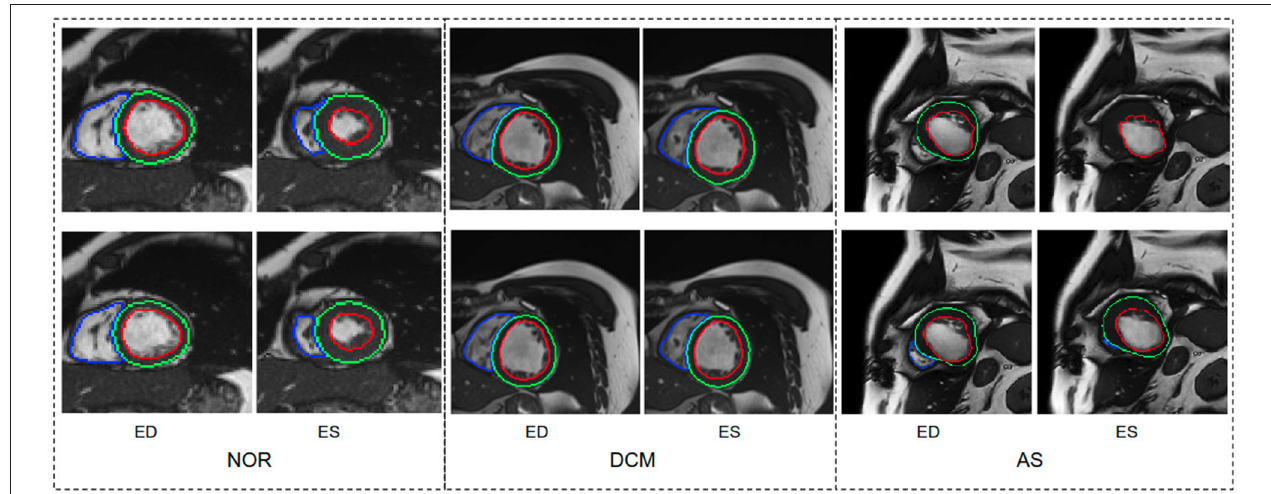
FIGURE 3 | Visualization of good segmentation examples selected from three patient groups. NOR (without cardiac disease), DCM (dilated cardiomyopathy), AS (aortic stenosis). Row 1: Ground truth (manual annotations); row 2: predicted results by the UKBB model. Each block contains a slice from ED frame and its corresponding ES one for the same subject. This figure shows that the UKBB model produced satisfying segmentation results not only on healthy subjects but also on those DCM and AS cases with abnormal cardiac morphology. The AS example in this figure is a patient with aortic stenosis who previously had a myocardial infarction. Note that this AS case is from BSCMR-AS dataset where the MYO and RV on ES frames were not annotated by experts.